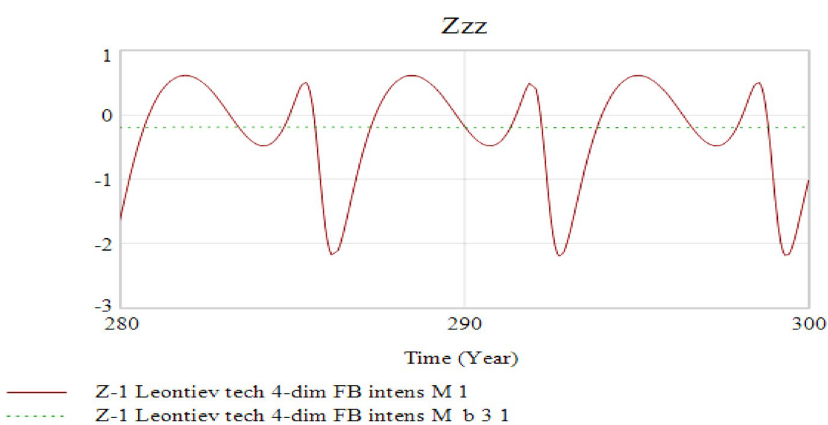
Fig. 14 Signs and amplitude of ∂ ˙ z for two limit cycles (solid curve for the first, dotted curve for the second) ∂ z involving unstable stationary state X b (43) in L-2, years 280–300